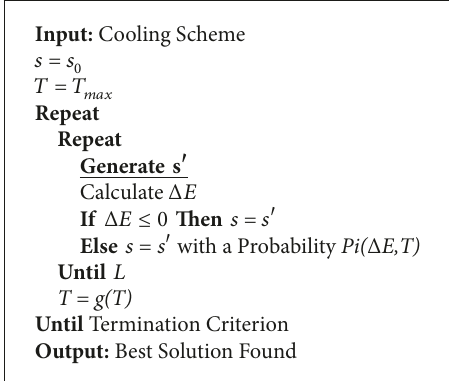
Algorithm 2: Simulated Annealing (adapted from